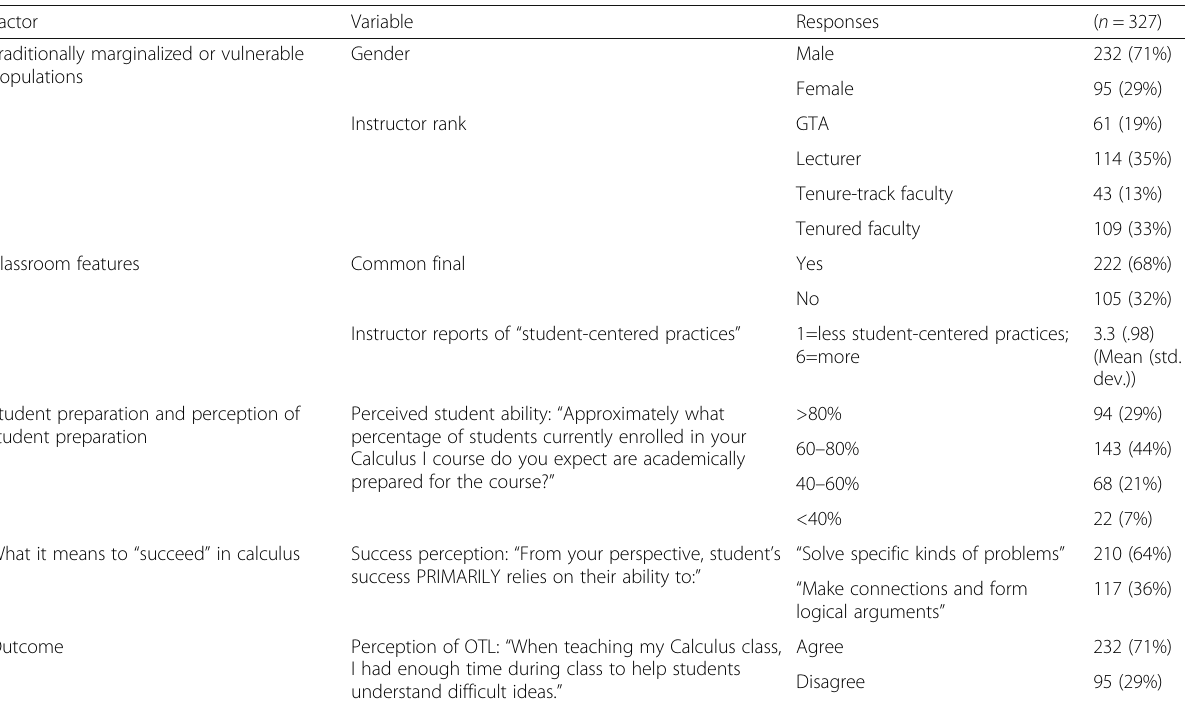
Table 5 Instructor summary